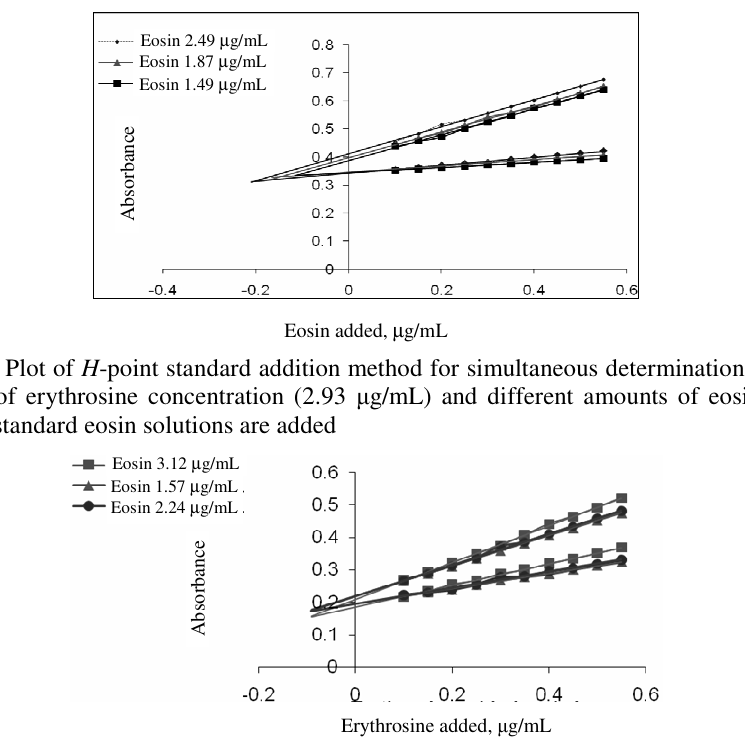
Figure 7. Plot of H -point standard addition method for simultaneous determination of fixed amount of erythrosine concentration (1.46 µ g/mL) and different amounts of eosin, when different standard erythrosine solutions are added